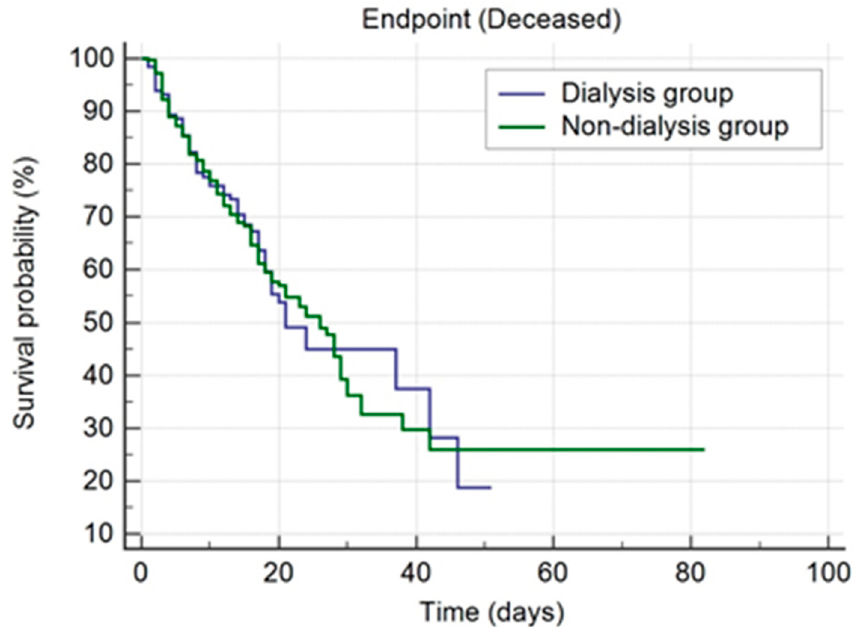
Figure 4. The curves of survival for non-dialysis and dialysis groups. The curves of survival for the two groups were not significantly different—Chi- square = 0.002356, df = 1, p = 0.9613 (Log-rank test). In addition, we obtained an HR of 0.9613 (95% CI of 0.7339 to 1.3426), which represents a measure of how rapidly the event of interest occurs (death). This HR was not significantly different from the value one (corresponding to equal hazards), since the confidence interval included the value